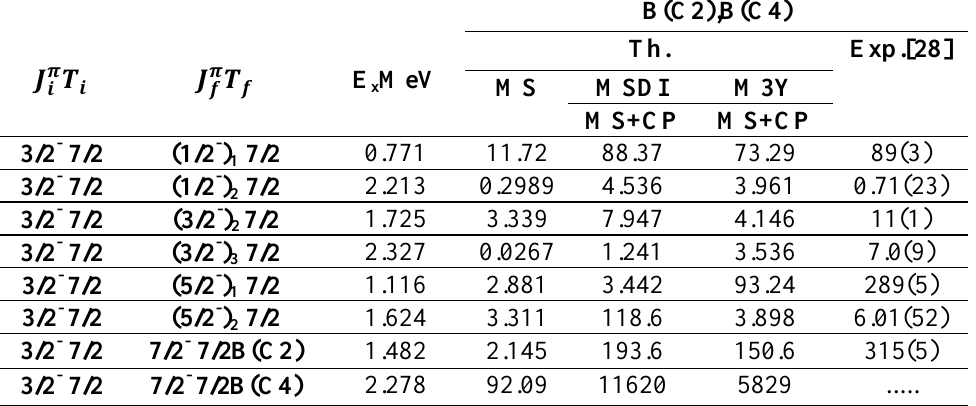
Table 1: Theoretical calculations of the reduced transition probabilities B (CL,0 + →L) in units of e 2 fm 2L in comparison with experimental values for 65 Cu nucleus